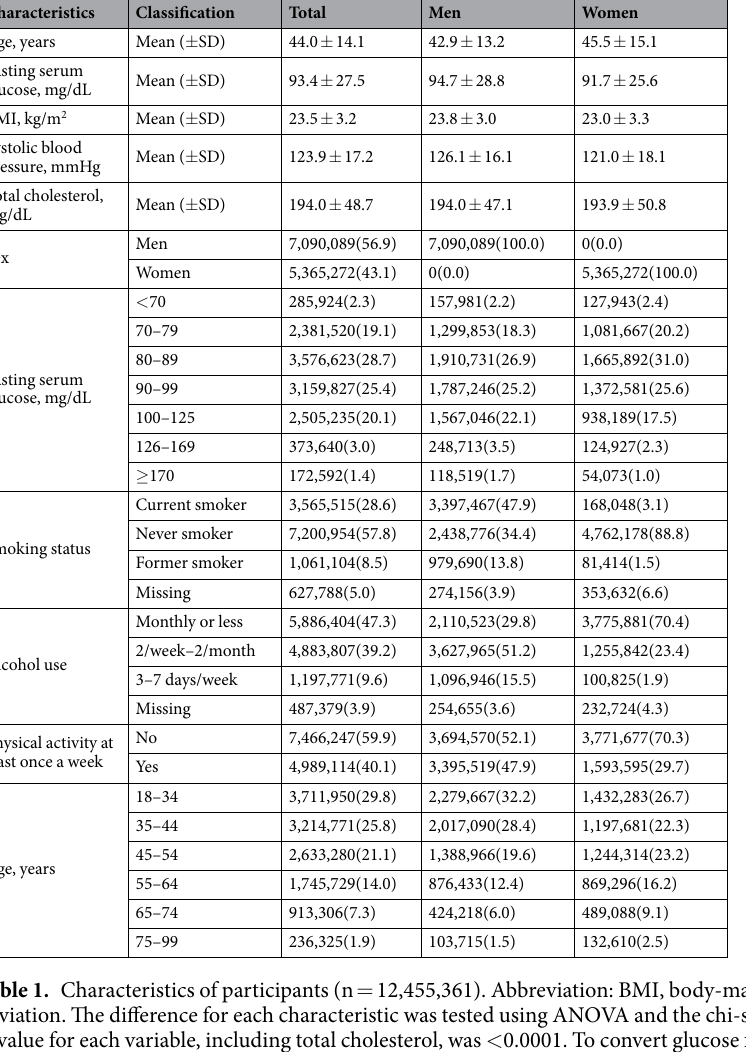
to 3.05) higher levels of fasting glucose than women. In men, the mean fasting glucose increased with age up until 62–63 years, while in women it did not substantially change up to 28–29 years and thereafter increased with age up to 86–99 years (Fig. 1, Table S3). Men and women had generally the same mean glucose levels at 18–23